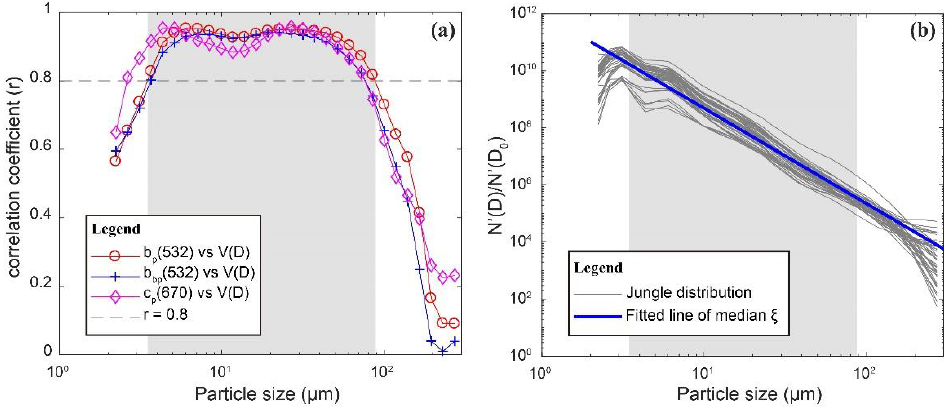
Figure 8. ( a ) Correlations between V(D) and b p (532), b bp (532), and c p (670) in all size ranges (the gray region shows the particle size range within the correlation coefficient r > 0.8 for b p (532)). ( b ) The “Junge distribution” for the particle number concentration (the blue line represents the fitted line of the median PSD slope (ξ = 3.55) of all the data).